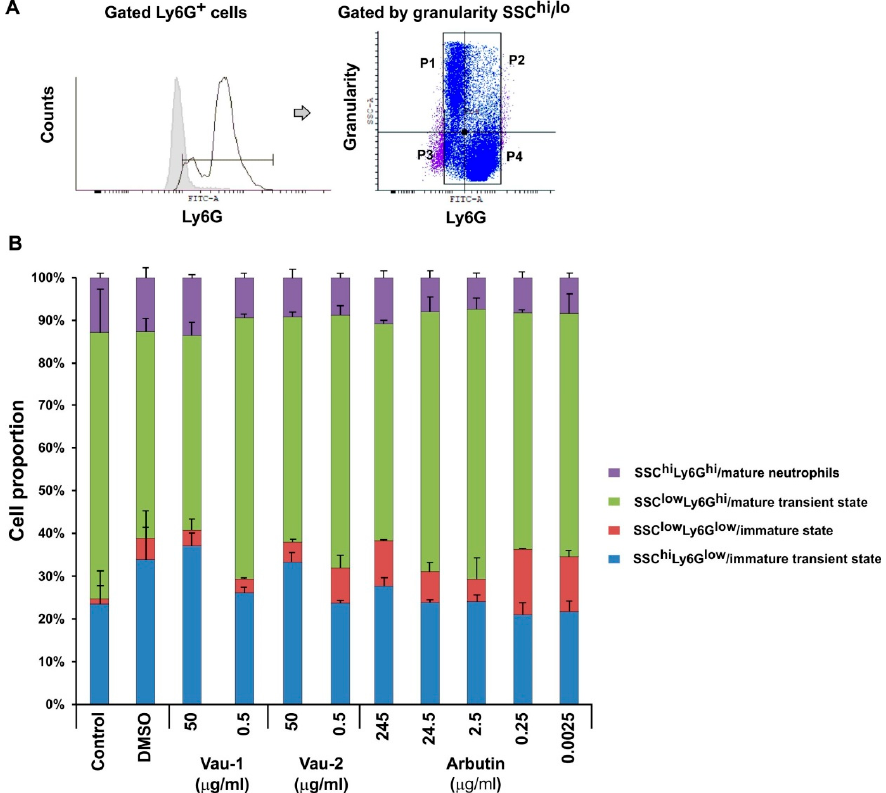
Figure 4. Effect of Vau-1/Vau-2 extracts or arbutin on proportion of neutrophils at various maturation states. ( A ) Gating strategy for neutrophils. The first panel shows the histogram for Ly6G expression and gating of Ly6G + positive cells. The second panel shows the dot-plot histogram with scales for Ly6G + cells vs. SSC-A (the size surface volume), that determines the shape and granularity of the BM-derived neutrophils. The following populations were defined on the basis of SSC-A and Ly6G positivity (staining with fluorescein isothiocyanate (FITC)-labelled antibody against Ly6G). Upper Left (P1 gate)—SSC hi Ly6G low immature transient cells; Upper right (P2 gate)—SSC hi Ly6G hi mature cells; Lower left (P3 gate)—SSC low Ly6G low immature cells; Lower right (P4 gate)—SSC low Ly6G hi mature transient cells; ( B ) Proportion of neutrophils at various maturation states in BM cells incubated in the presence or absence of Vau-1, Vau-2 or arbutin for 36 hrs. Data represent mean ± SD of sample from 2 experiments with neutrophils isolated and pooled from 7 mice and assayed in duplicate.